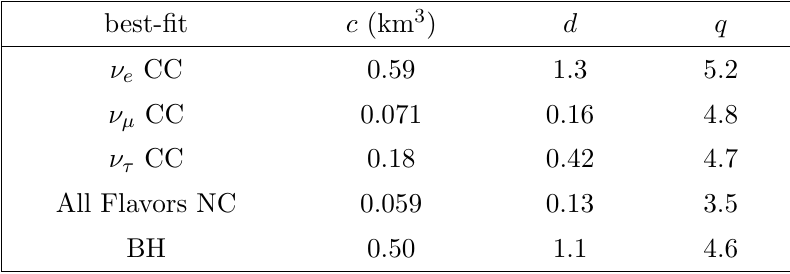
for black hole production is taken to be the e(cid:11)ective mass as a function of the true deposited energy obtained from [70], since neutrinos deposit almost all of their energy in the